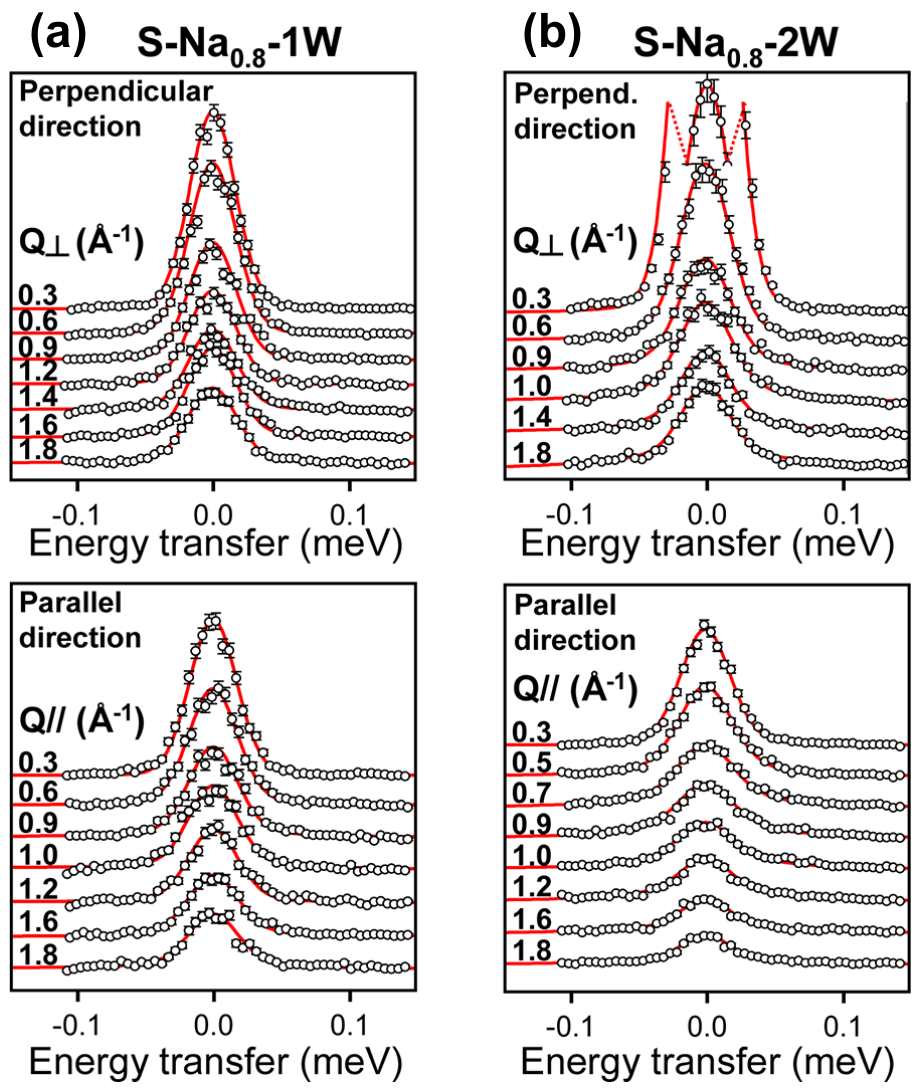
Figure 5. Direct comparison between experimental Quasi-Elastic Neutron Scattering spectra (open circles) and their numerical counterpart (red line) evaluated by MD simulations. Data were obtained for low-charge (0.8 e/uc) synthetic saponite in the direction parallel ( bottom ) or perpendicular ( top ) to the clay layer and for ( a ) mono-hydrated state and ( b ) bi-hydrated state. Reprinted with permission from Ref. [28]. Copyright (2012) American Chemical